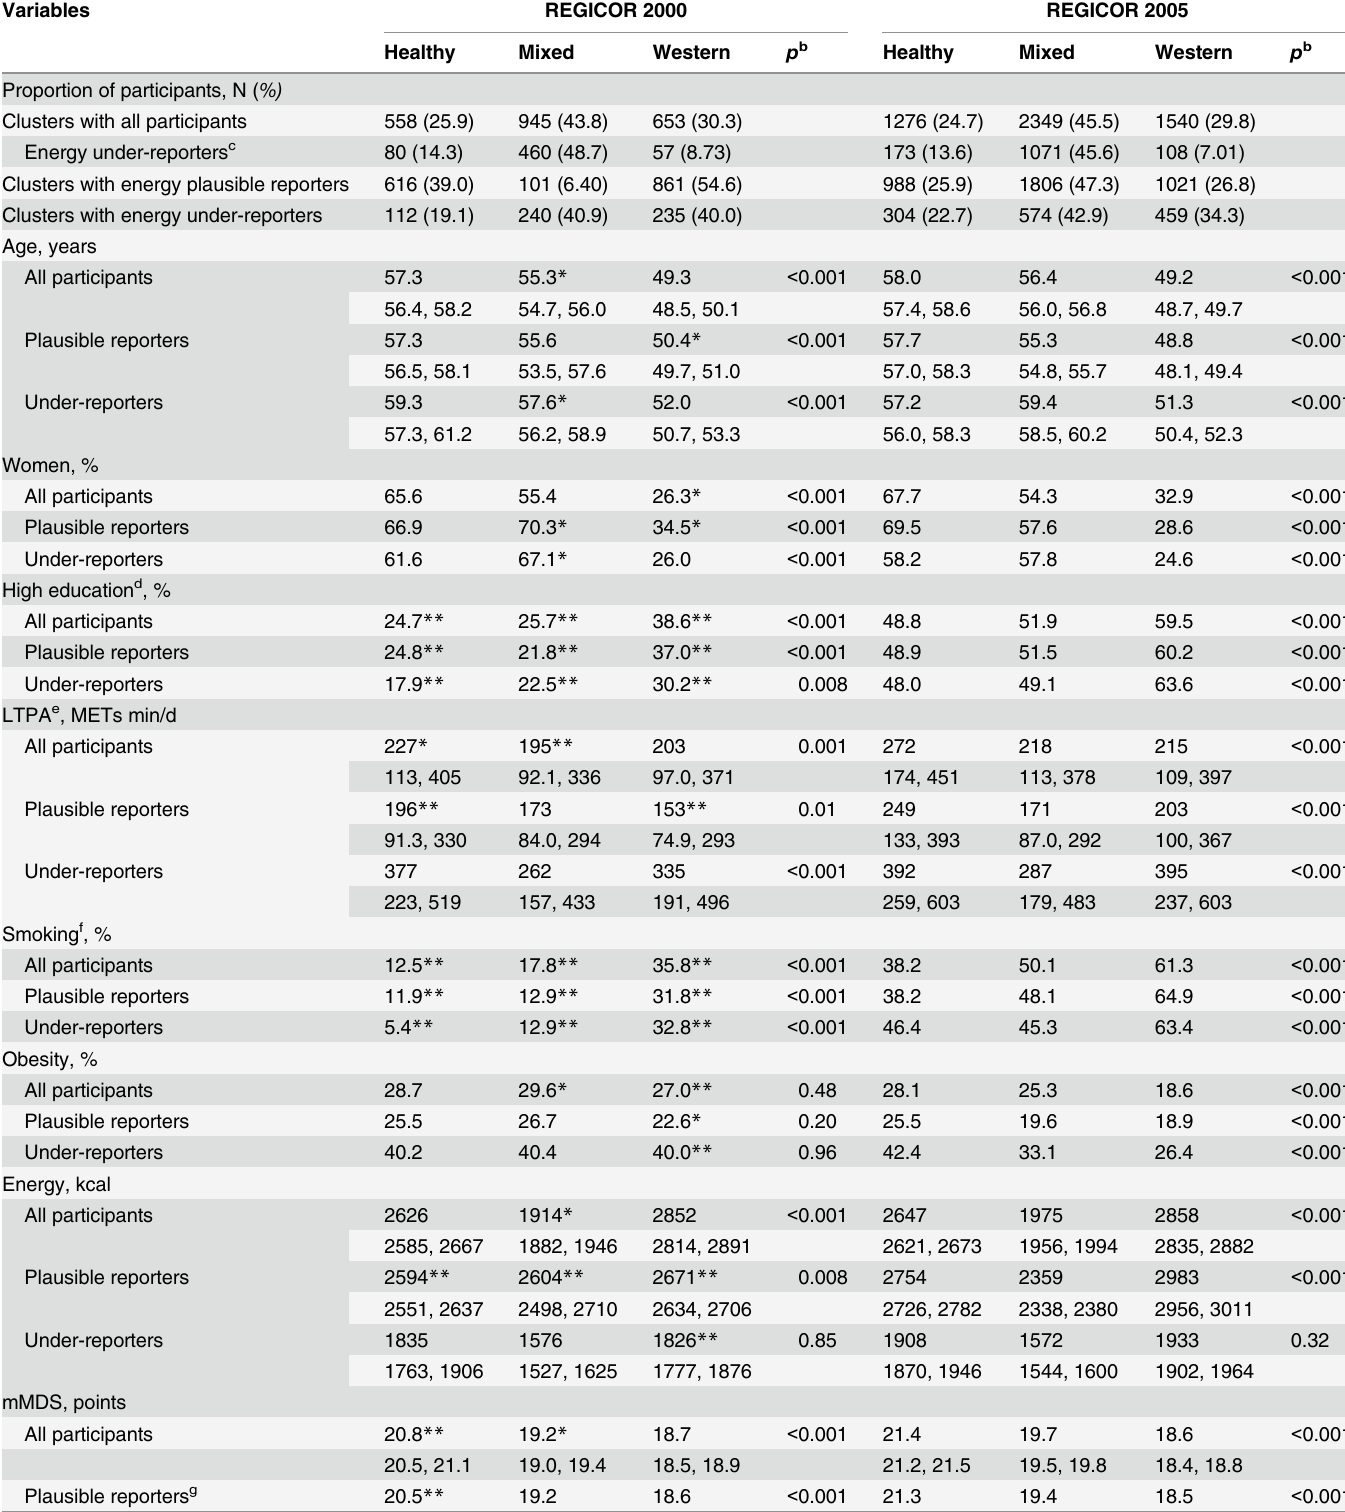
Table 1. General characteristics of clusters in the REGICOR 2000 and 2005 surveys.